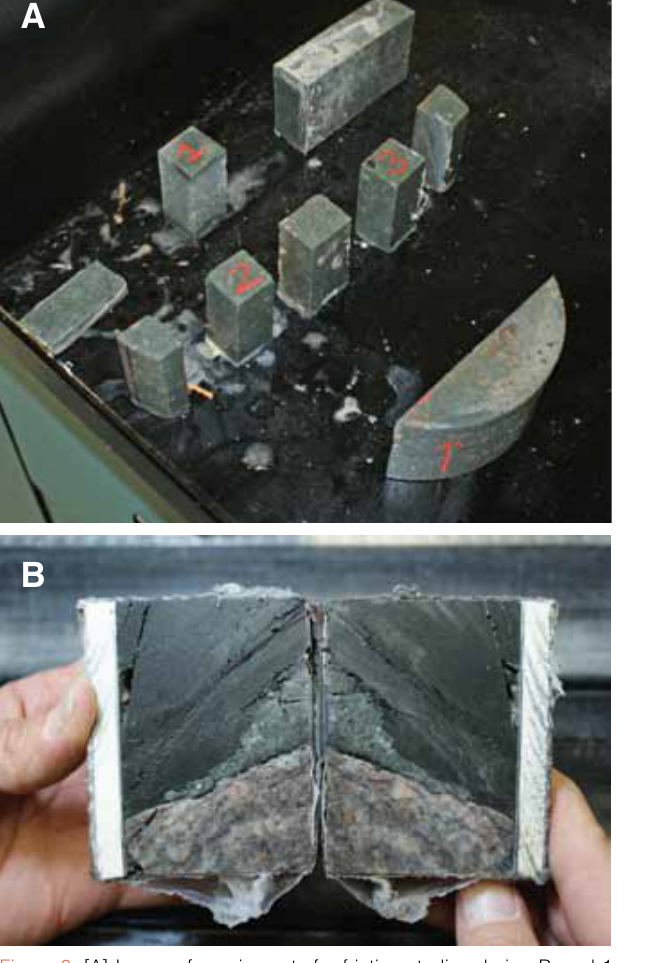
Figure 3. [A] Image of precise cuts for friction studies during Round 1 that documents the sampling process and was uploaded into the Core Viewer. [B] Example of Round 2 image within the SAFOD Core Viewer. Section E-R1-S5, showing a fault contact between dark grayish-black siltstone and grayish-red pebbly